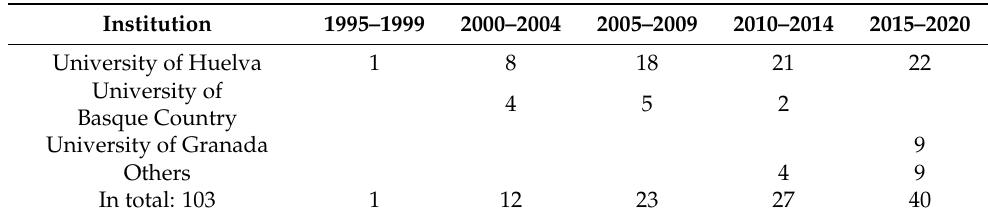
Table 6. Distribution of the papers published involving the rheology of bituminous binders in the period 1995–2020 in Spain (source, Web of